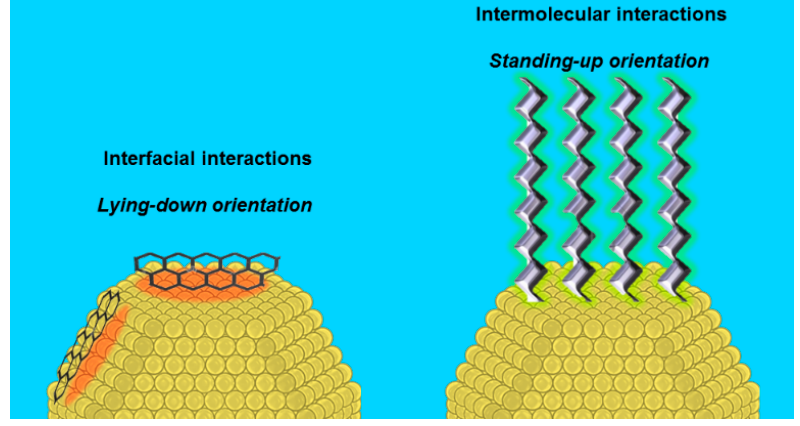
Figure 8. The role of interactions in determining the orientation of ligand molecules.